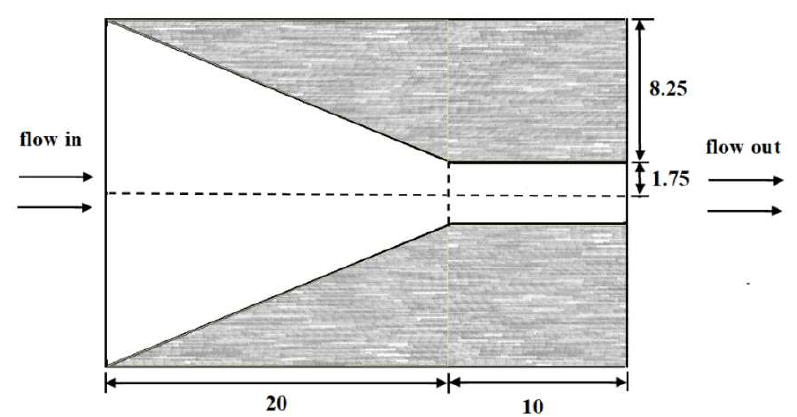
Figure 1. Sketch of the hollow tapered cylinder, unit: mm.